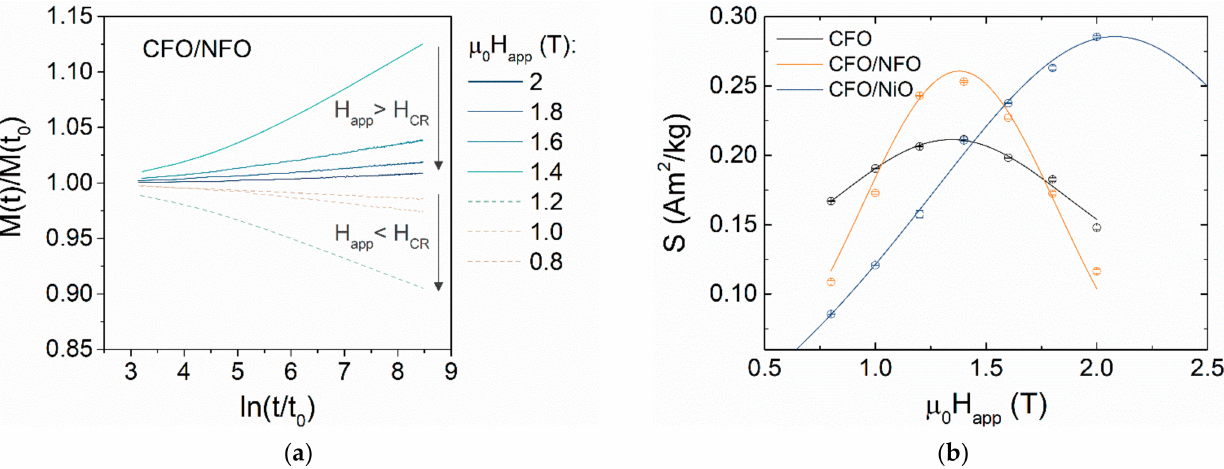
Figure 5. ( a ) normalized M(t) measured at different values of µ 0 H app after saturation at − 5 T for CFO/NFO sample; ( b ) magnetic viscosity S as a function of the applied field µ 0 H app for all